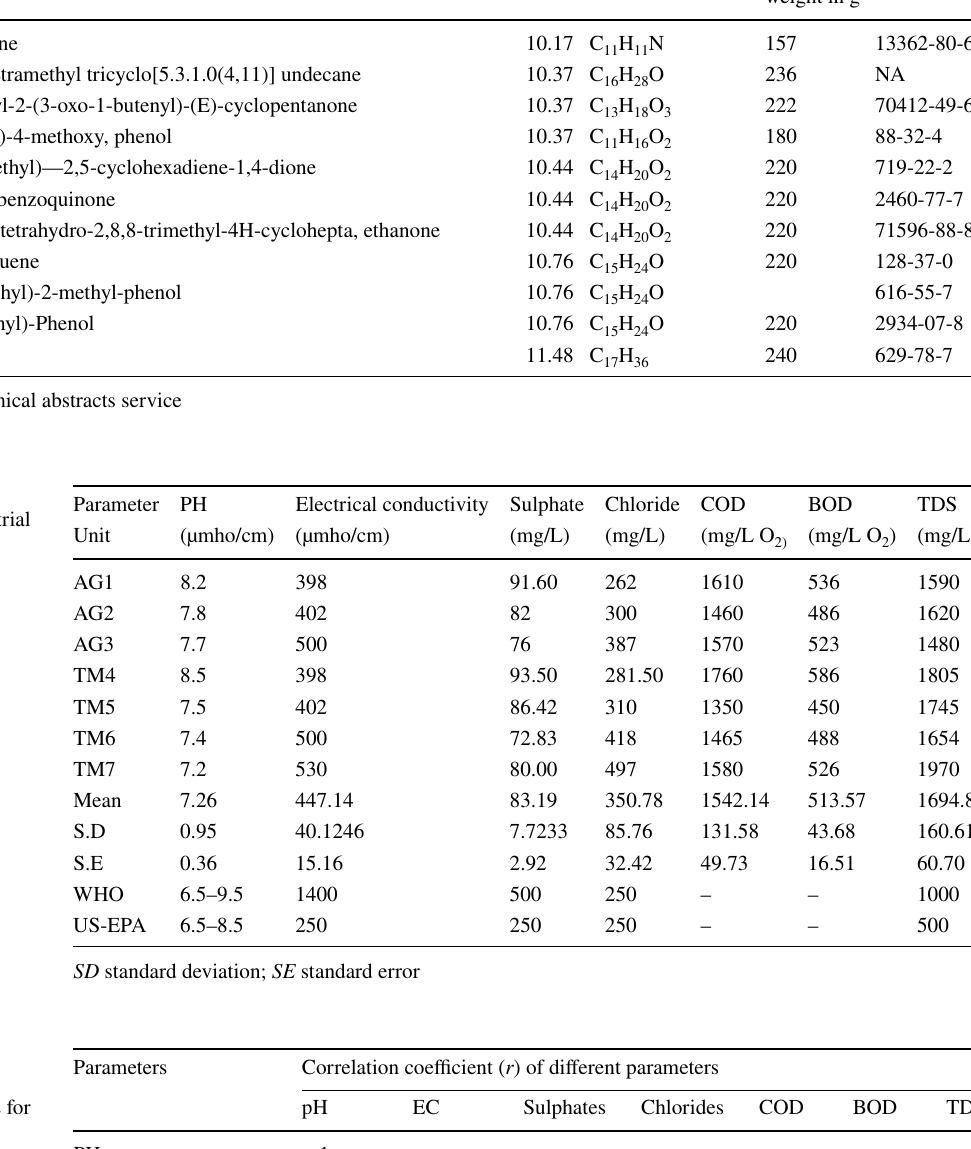
coefficient ( r ) of different physico-chemical parameters for waste water effluent